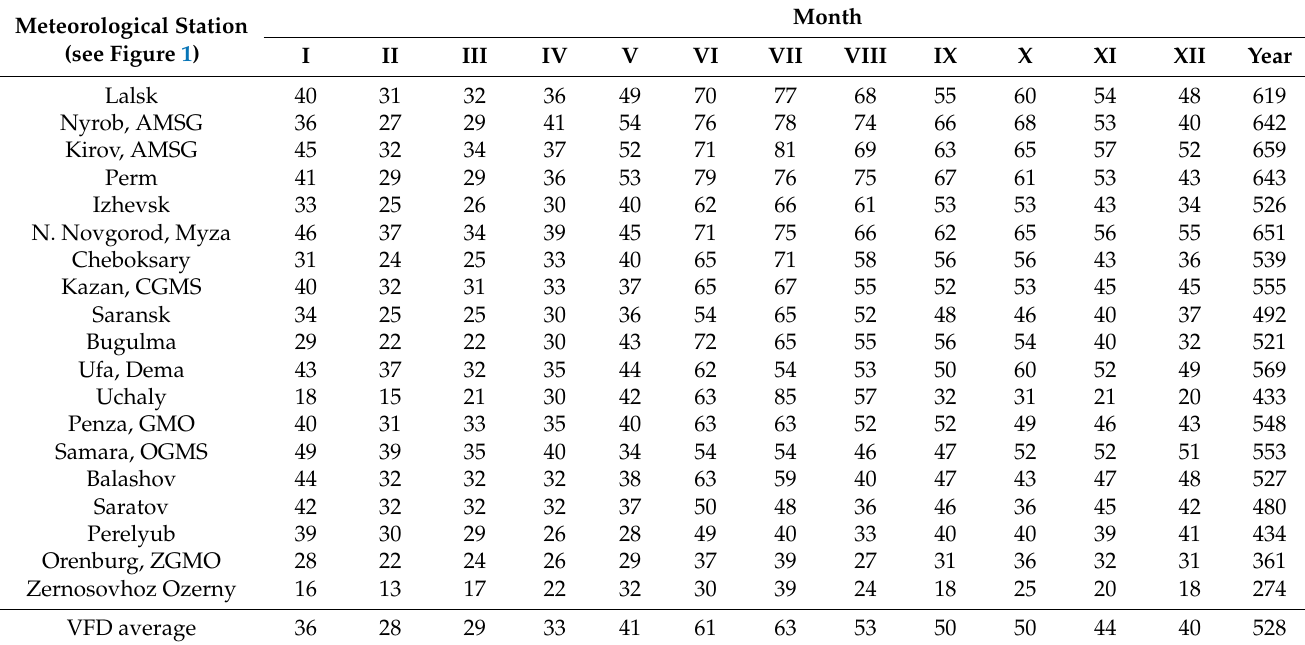
Table 3. Long-term (1966–2021) average values of monthly and annual precipitation (mm) in the Volga Federal District (VFD).